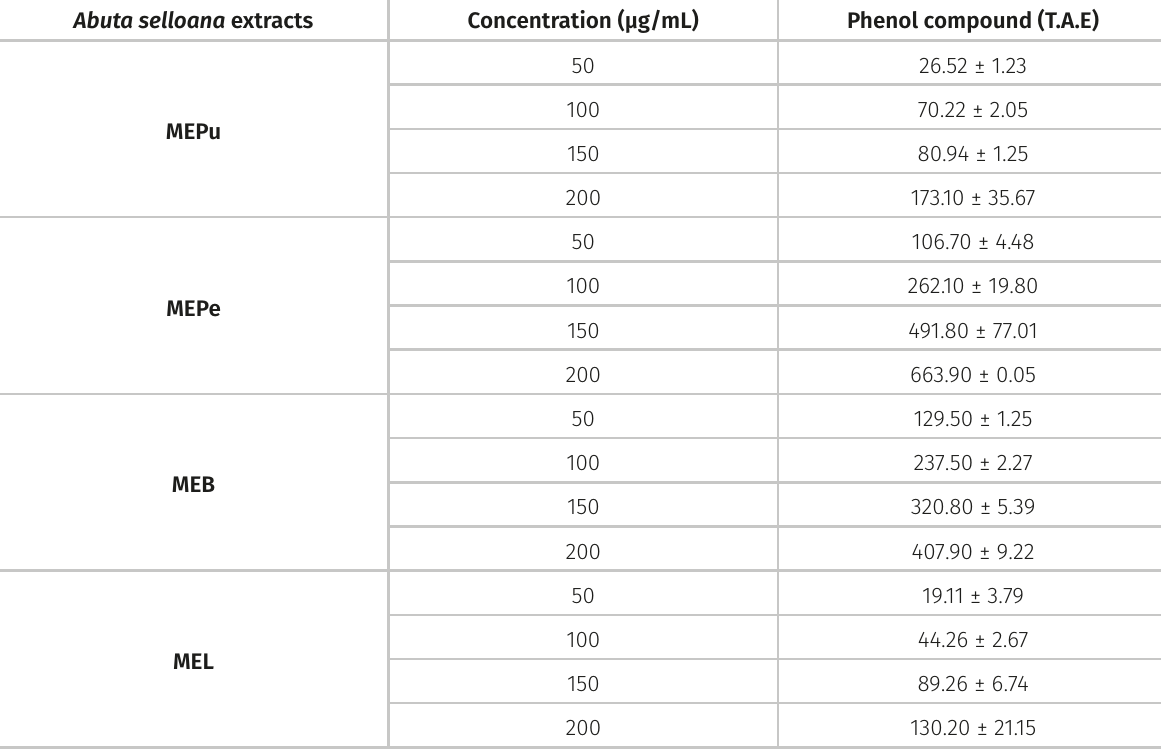
Table II. Total phenolic content of the methanolic extracts obtained from different parts of A. selloana. Abuta selloana